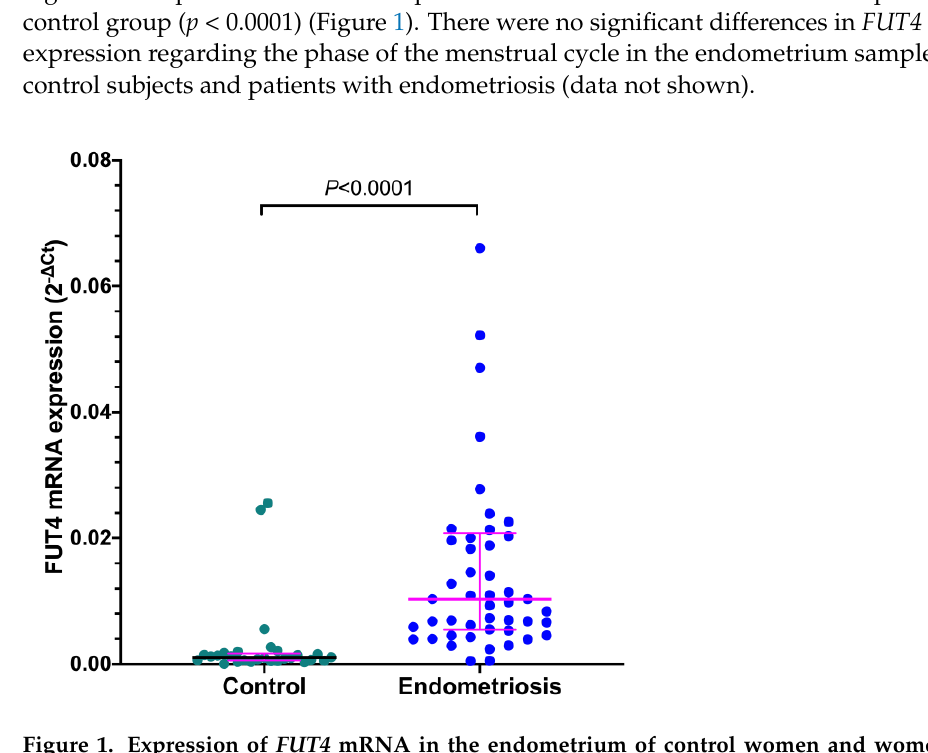
Figure 1. Expression of FUT4 mRNA in the endometrium of control women and women with endometriosis. Expression of FUT4 mRNA was evaluated by qRT-PCR in the endometrium of control women ( n = 28) and the endometrium of women with endometriosis ( n = 49). The data are shown as scatterplots with the median and interquartile range. Samples from the endometriosis group displaying relative expression values over 0.08 ( n = 3) are not included in the graph. Statistically significant differences between groups were computed by the Mann–Whitney U